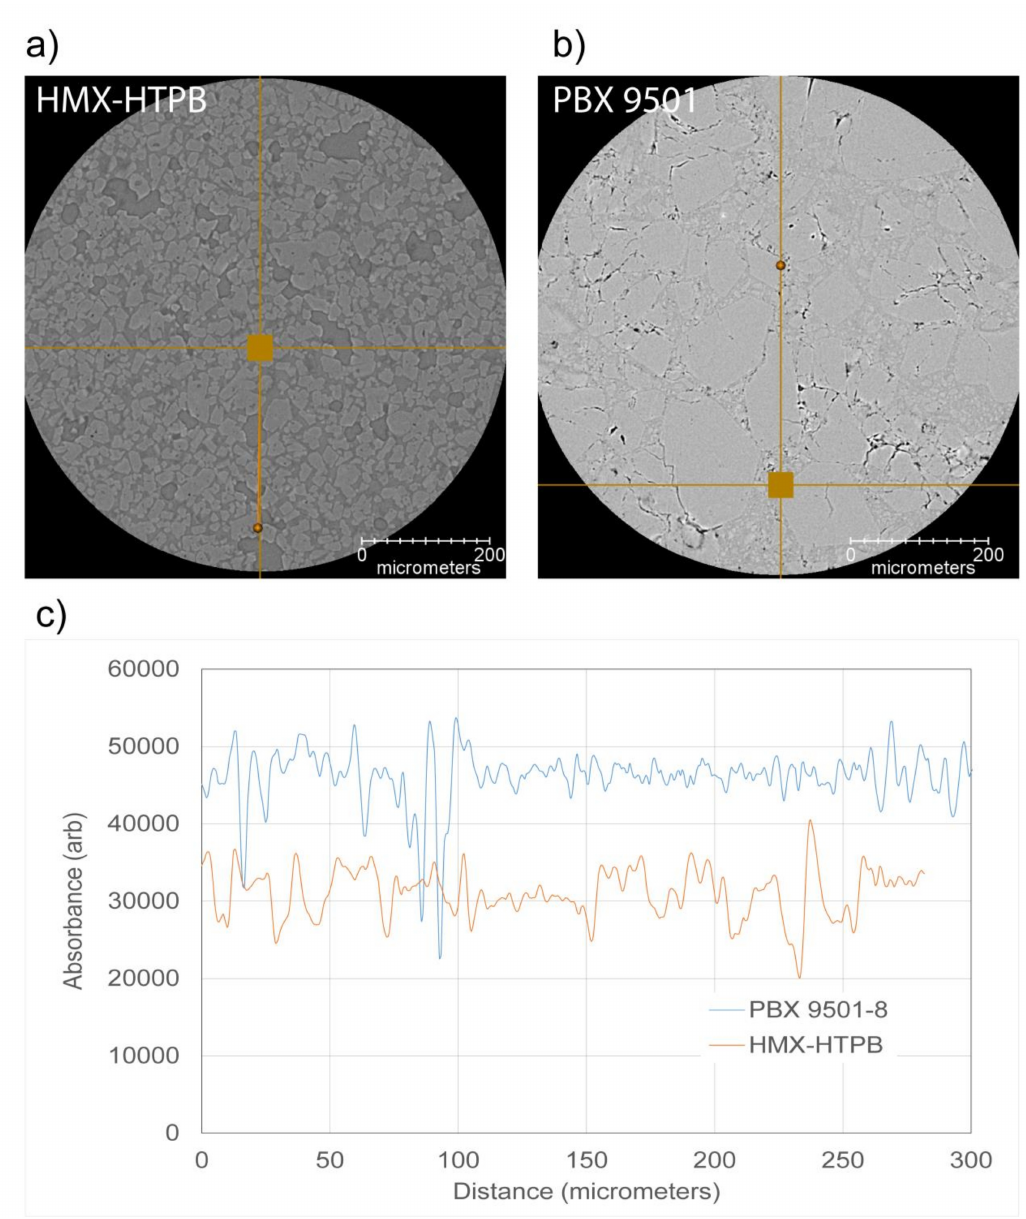
Figure 4. Reconstructed slice through HMX-HTPB ( a ) and PBX 9501 ( b ) composite comparing the gray scale di ff erences between the crystals and the binder. Line profiles extracted from the images show the improved signal-to-noise in the HMX-HTPB sample ( c